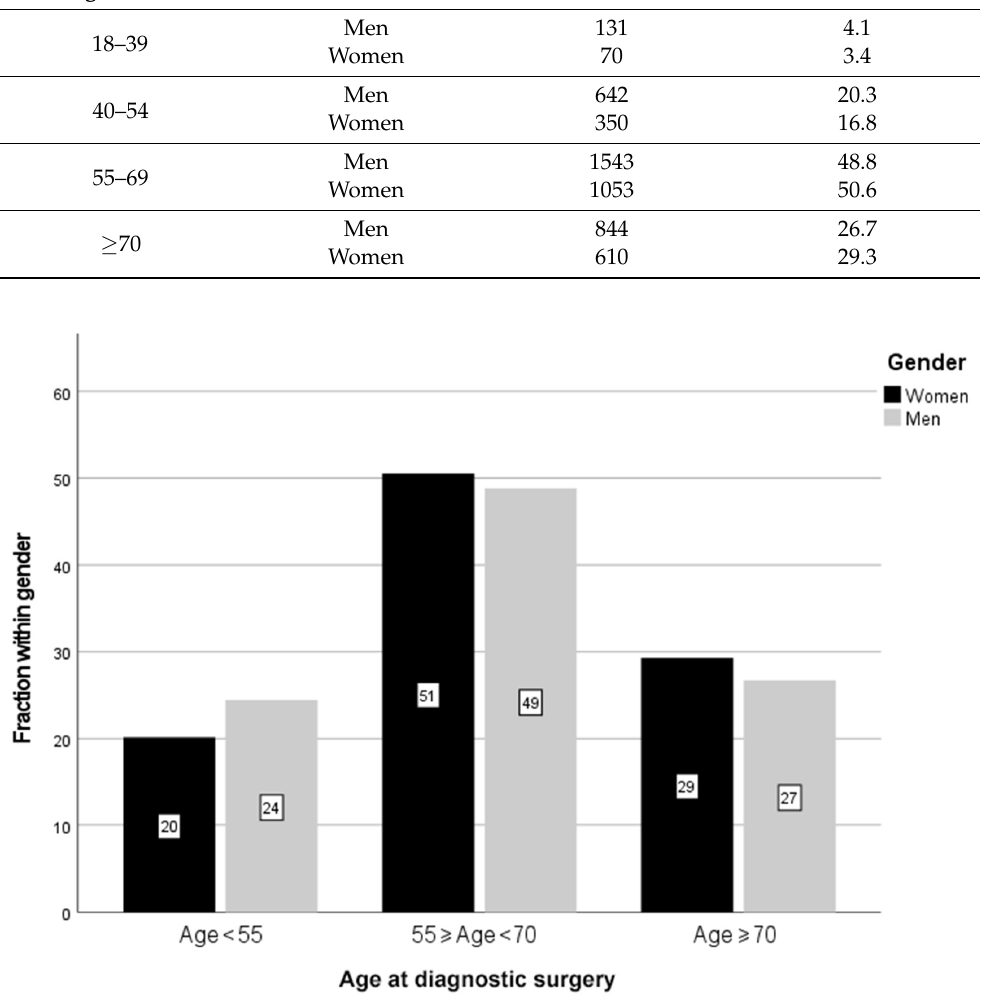
Figure 1. Age at the time of diagnostic surgery for men and women. Only 20% of all women were diagnosed below the age of 55 years, while for men this was 24%. A larger proportion of women were diagnosed in the age groups ≥ 55 & <70 years and ≥ 70 years than for the men ( p = 0.001), using the Chi square test. The faction within each sex is reported in percent (%).